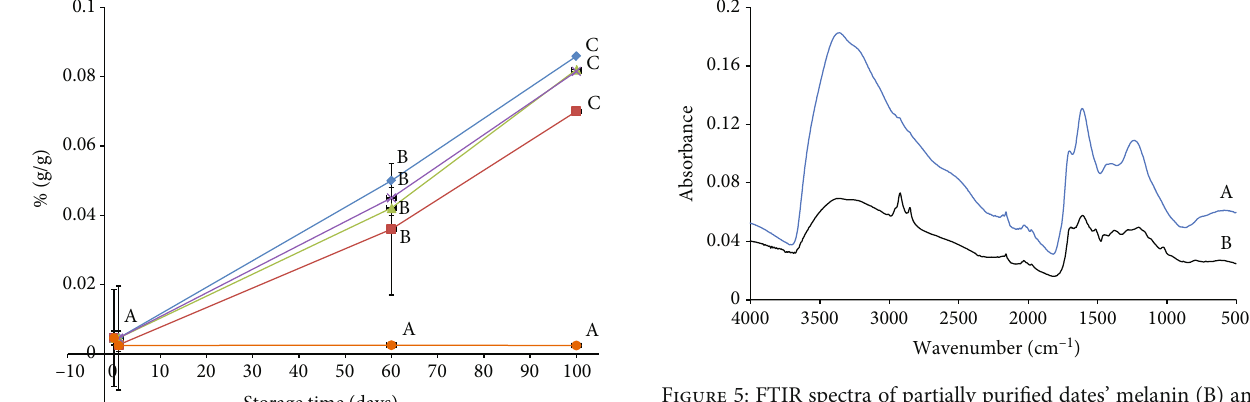
Figure 5: FTIR spectra of partially puri fi ed dates ’ melanin (B) and reference melanin